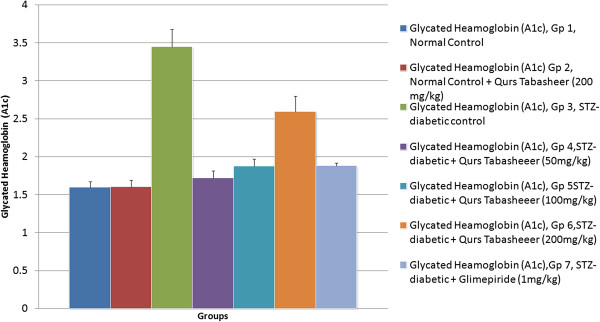
Effect of Qurs Tabasheer on glycated heamoglobin (A1c) (%) at different concentrations on normal and STZ induced diabetic rats, compared to standard drug Glimepiride; values are mean ± SEM; n = 6; *P < 0.05; **P < 0.01; ***P < 0.001; P > 0.05 is considered as non-significant (ns).